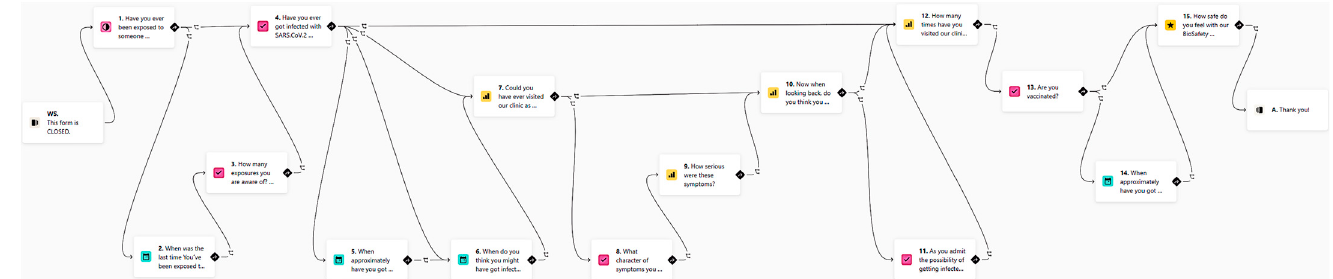
Figure 1. Example of logic behind the online smart form. English version of the survey evaluation in this protocol. URL: https://sangreazul.typeform.com/BioSafety-ENG (accessed on 15 December 2021).